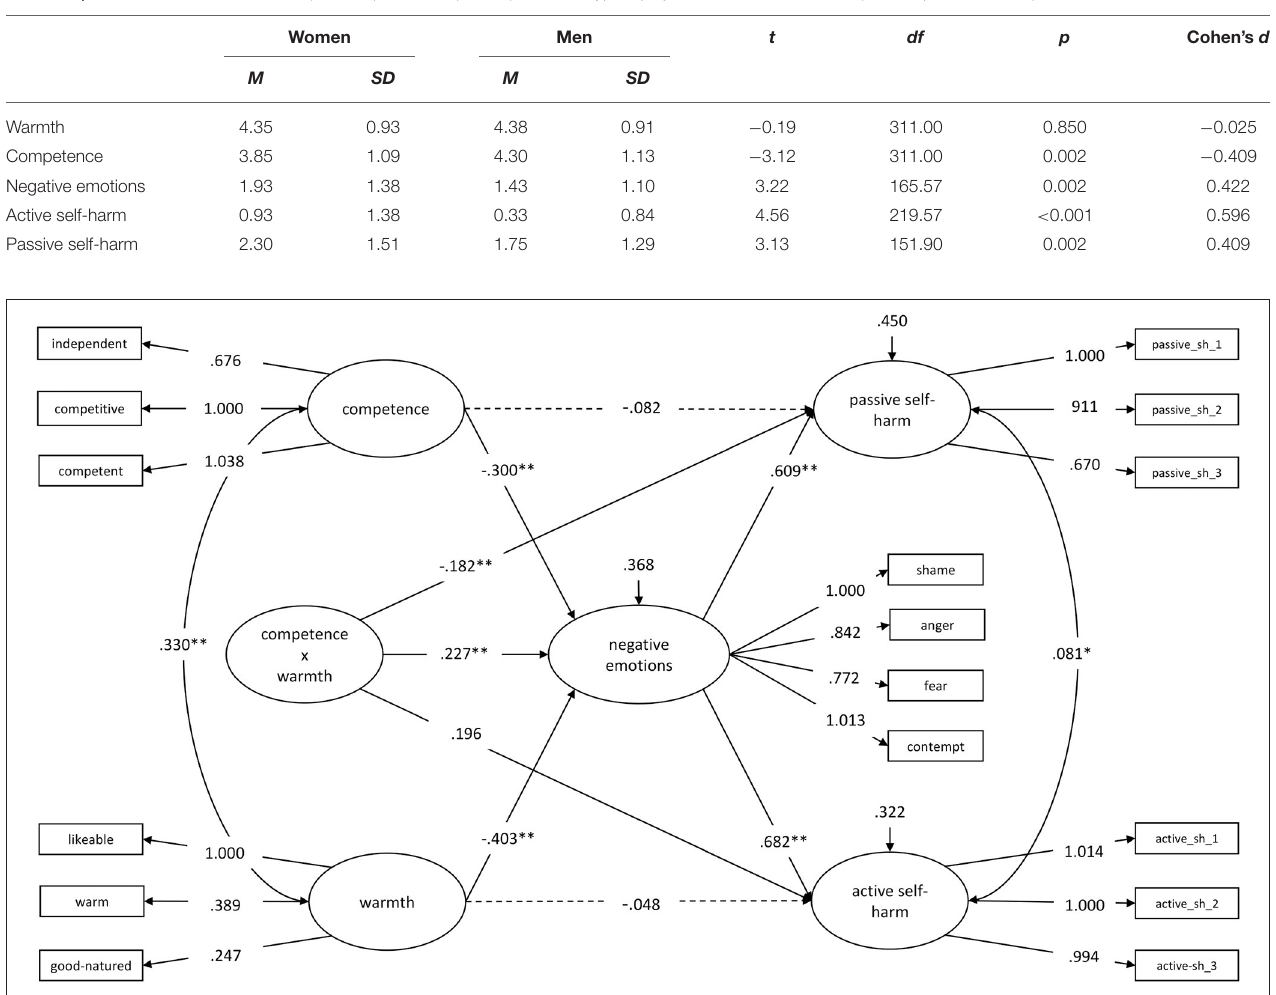
FIGURE 2 | Warmth, competence, and their interaction (warmth x competence), predicting passive and active self-harm via negative emotions (Model 2.0). Dashed lines are not significant ( p > 0.05). * p < 0.05, ** p < 0.01. sh =